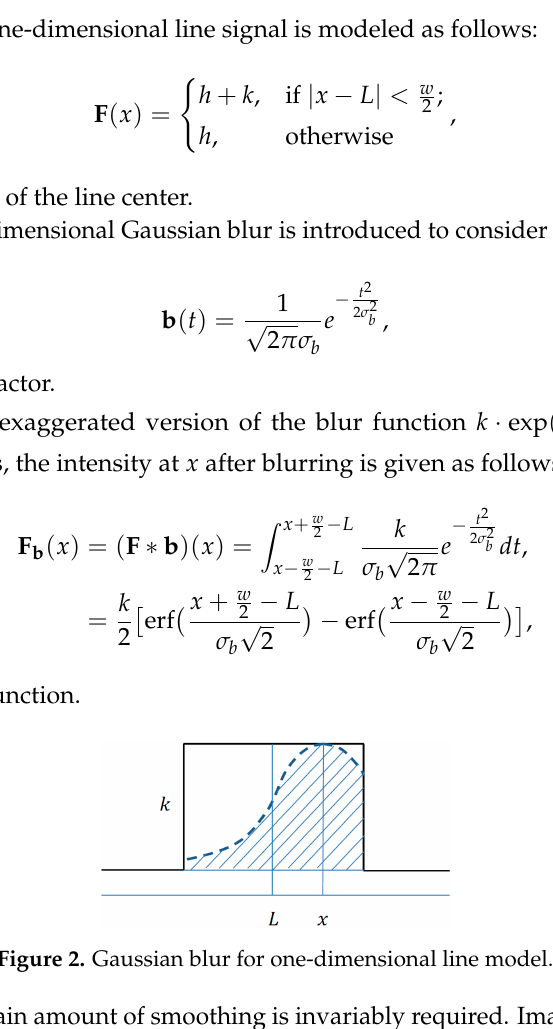
Figure 1. One-dimensional line profile model used in current study.